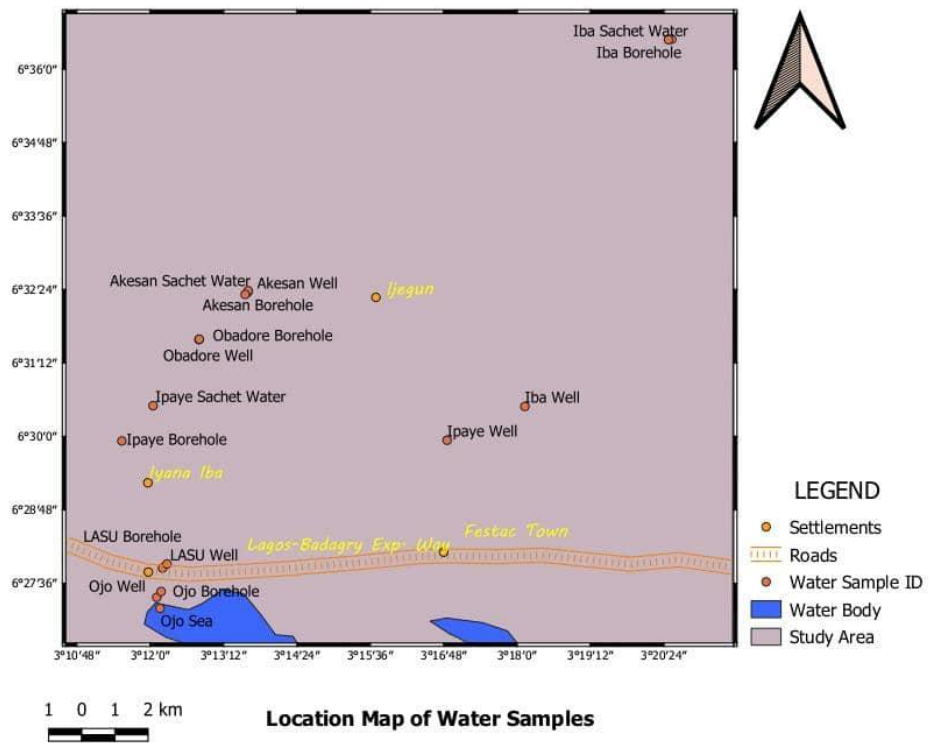
Figure 1. Map of sites of water collection from Ojo Local Government area in